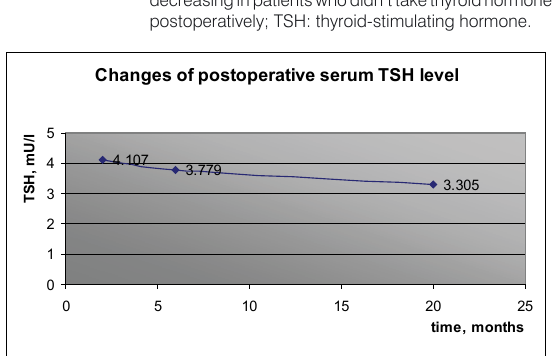
Figure 1c. Scatter diagram of the ratio of the remaining thyroid weight to patient’s weight (g/kg) versus the post- hemithyroidectomy TSH level (postoperative TSH levels were measured 2 months after the surgery).